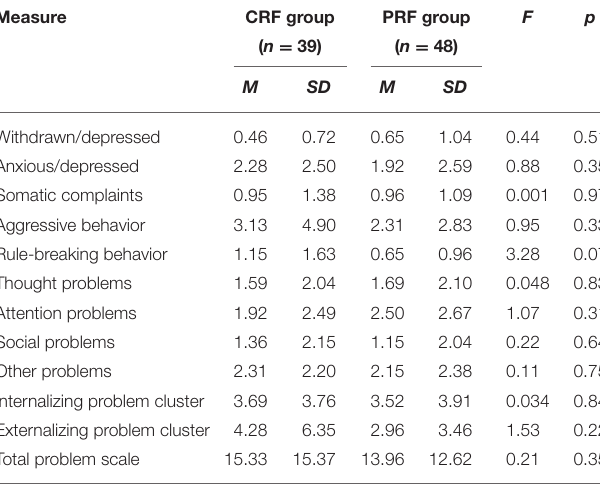
TABLE 2 | Means and standard deviations for subscales of the Child Behavioral Checklist (mother